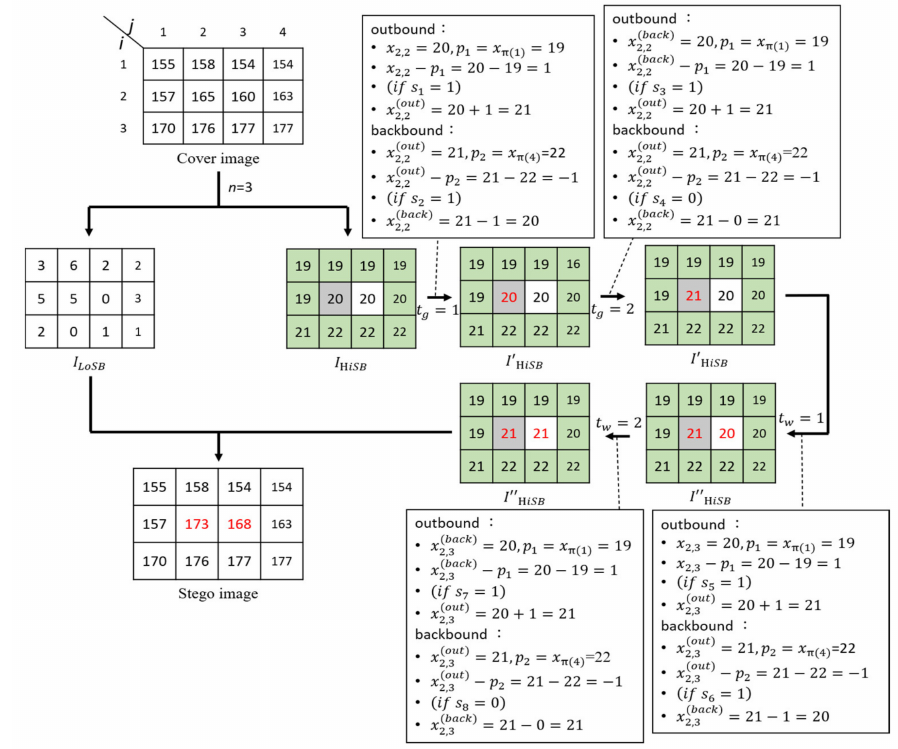
Figure 6. The example of secret data embedding